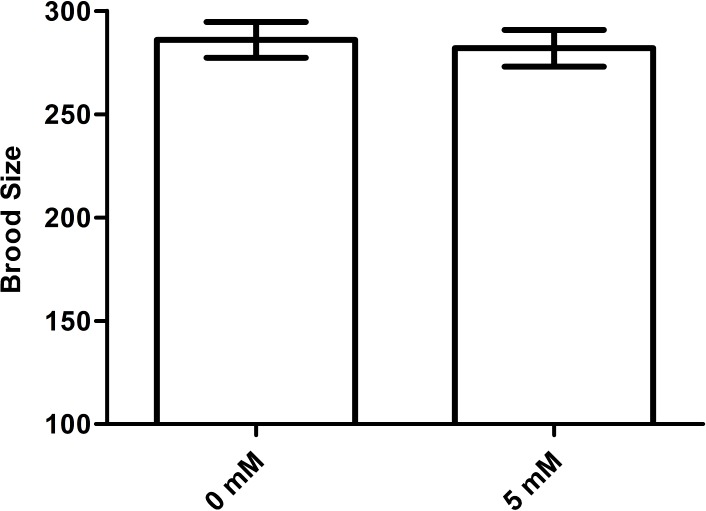
Effect of arbutin on brood size in C. elegans.There was no significant difference in the number of total progeny between arbutin-treated and untreated animals. Error bars represented the standard error of the mean (SEM) (N = 10 animals per group, p = 0.74).